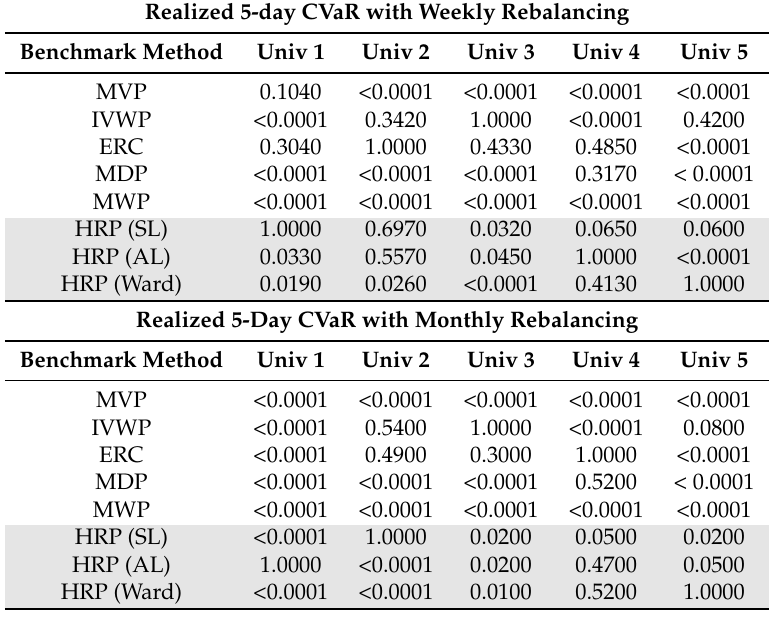
Table A4. p c -value of different benchmark portfolios based on the out-of-sample CVaR for different rebalancing horizons. The covariance forecast model is taken as DCC-GARCH.